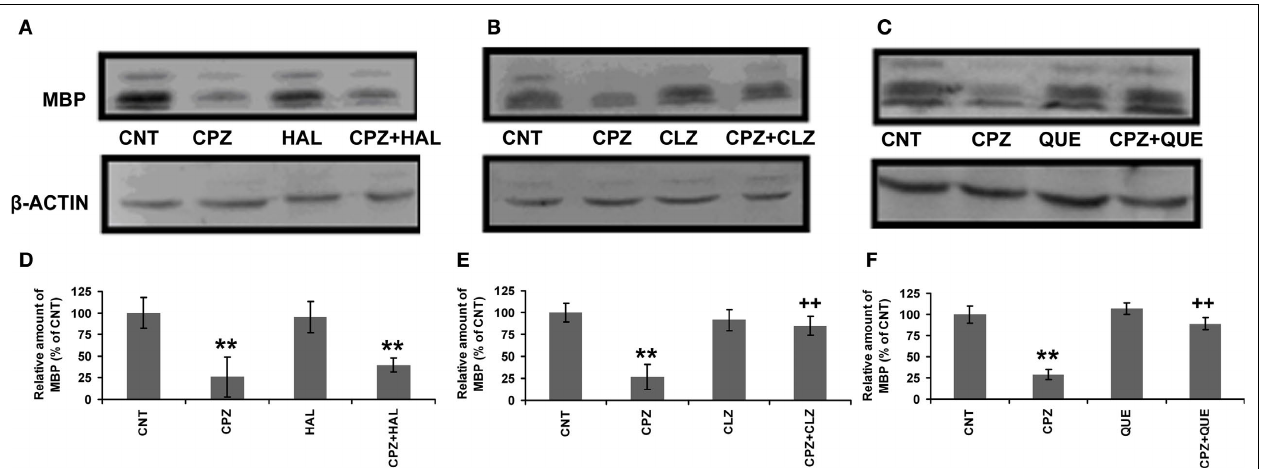
FIGURE 7 | Effects of antipsychotics on the CPZ-induced decrease in MBP in CP. Control and experimentally treated C57BL/6 mice were sacrifi ced on 43rd day after CPZ-exposure. The CP was dissected out of the brain and processed for Western-blot analysis to measure MBP levels. The upper photographs (A–C) are representative Western-blots from the HAL, CLZ, and